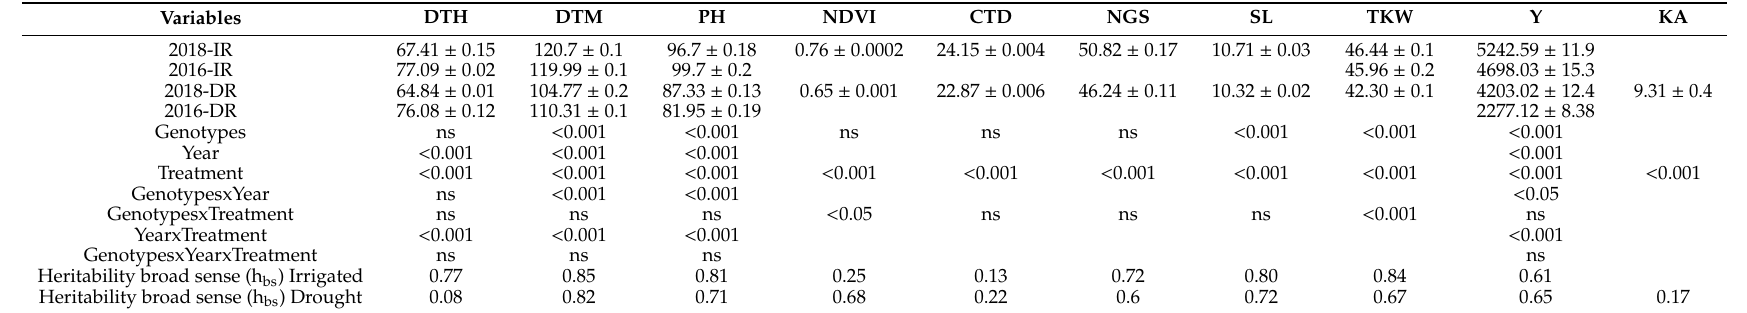
Table 1. Mean squares, standard error, and significance level of di ff erent plant